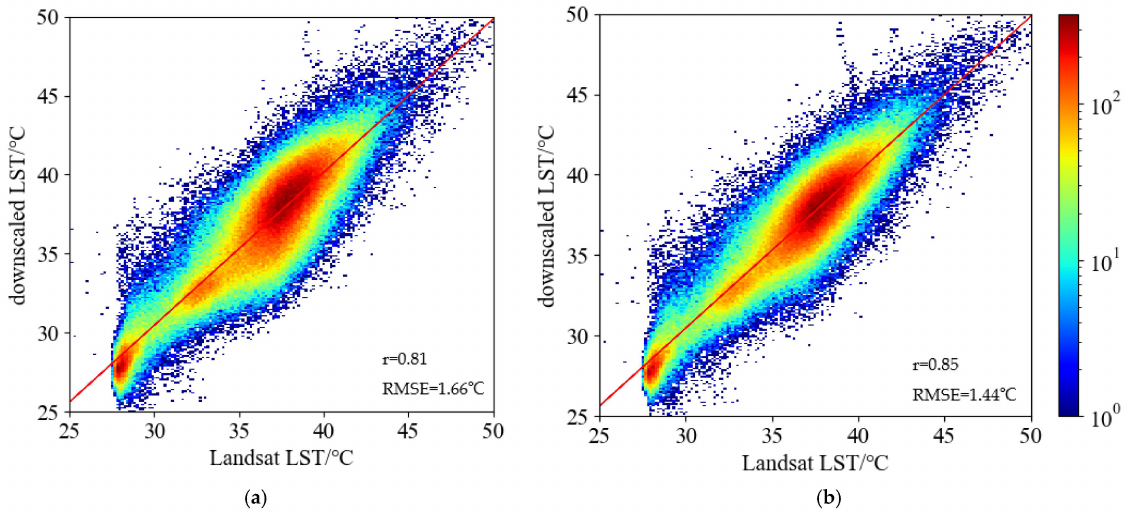
Figure 5. Scatterplots of the correlation analysis between downscaled LST and Landsat LST on the overall region at a 30-m resolution. ( a ) SSRFD result. ( b ) SSRFD-M result. Remote Sens. 2022 , 14 , x FOR PEER REVIEW